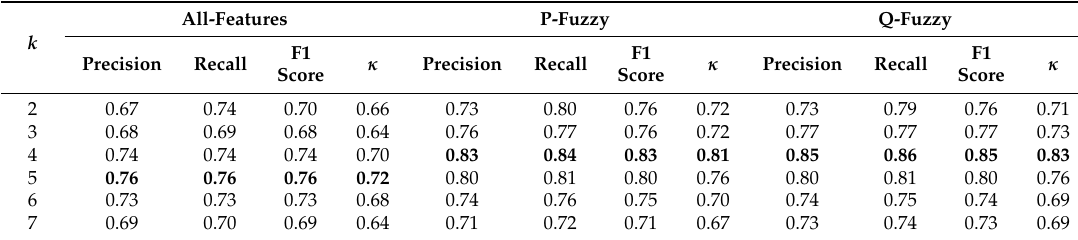
Table 5. Comparison of classification results for approaches with (i.e., P-Fuzzy and Q-Fuzzy) and those without prior feature selection (i.e.,